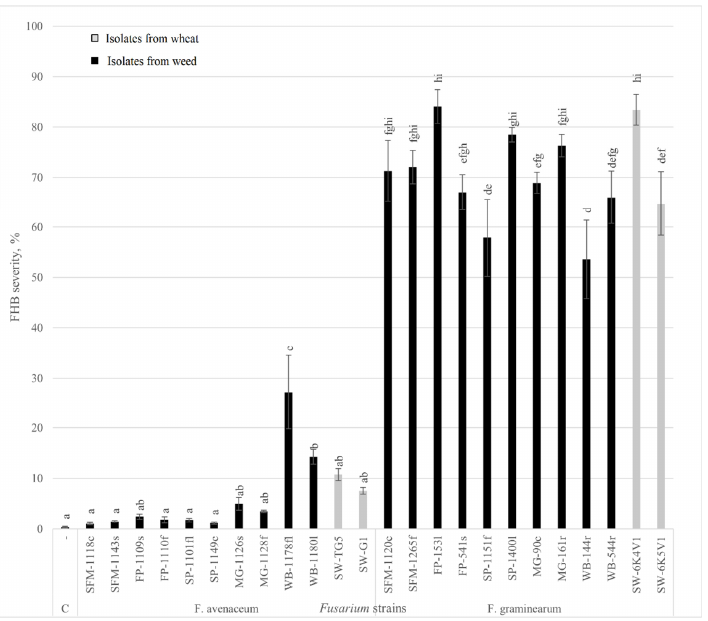
Figure 4. Fusarium head blight severity (FHB) in spring wheat heads inoculated with Fusarium iso- lates from weed and wheat (the percentage of FHB severity (±SEM) was calculated from the average of the four replications (20 heads per replication) inoculated wheat heads at 21 DPI. (Different letters (a–i) above the bars indicate statistically significant differences ( p < 0.05) between study treatments. C—water inoculated